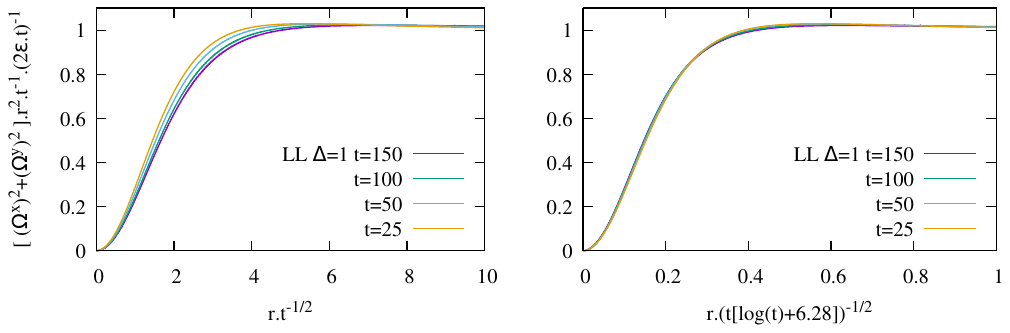
Figure 14: Ratio of the energy density computed in the perturbative approximation to the actual energy density. See text and Eq. (35) for details. The good curve collapse observed in the right panel indicates that this ratio obeys a scaling form similar to that of Ω z (compare with the bottom panel of Fig.